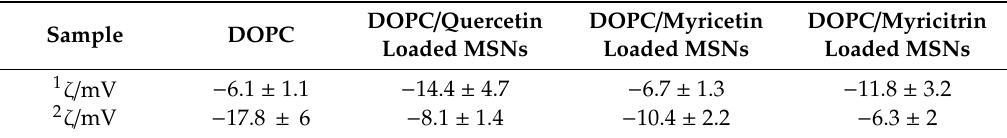
Table 4. Zeta potential values of DOPC liposomes ( γ = 0.5 mg mL − 1 ) with and without inserted flavonoids at 25 ◦ C before and after induced lipid peroxidation process by the addition of H 2 O